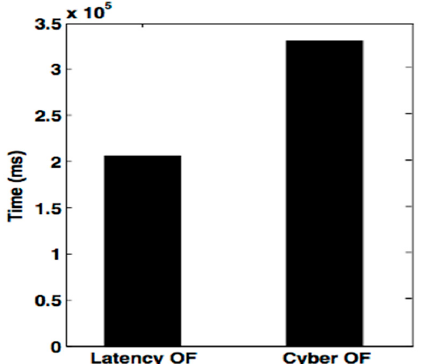
Figure 9. Comparison of the network lifetime of a latency-based objective function (latency-OF) and the cyber-physical objective function (Cyber-OF).